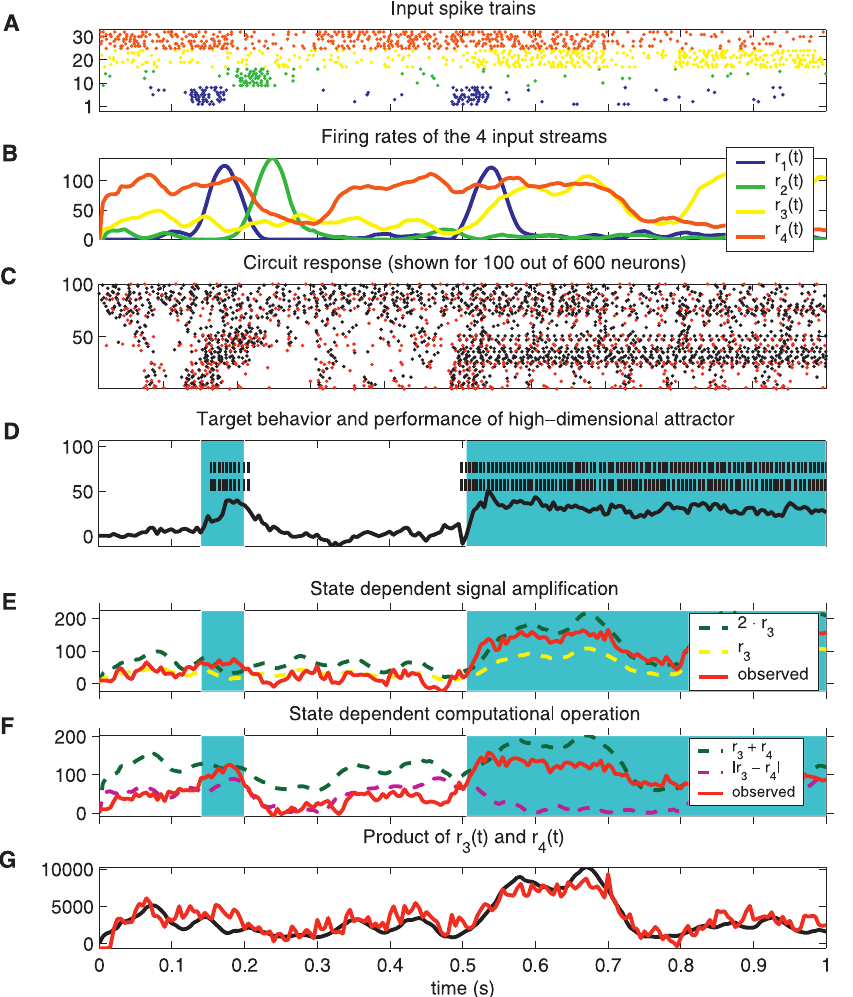
Figure 2. State-Dependent Real-Time Processing of Four Independent Input Streams in a Generic Cortical Microcircuit Model (A) Four input streams, each consisting of eight spike trains generated by Poisson processes with randomly varying rates r i ( t ), i ¼ 1, ... 4, rates plotted in (B); all rates are given in Hz. The four input streams and the feedback were injected into disjoint sets of neurons in the circuit. (C) Resulting firing activity of 100 out of the 600 I&F neurons in the circuit. Spikes from inhibitory neurons marked in red. (D) Target activation times of the high-dimensional attractor (blue shading), spike trains of two of the eight I&F neurons that were trained to create the high-dimensional attractor by sending their output spike trains back into the circuit, and average firing rate of all eight neurons (lower trace). (E,F) Performance of linear readouts that were trained to switch their real-time computation task depending on the current state of the high- dimensional attractor: output 2 (cid:3) r 3 ( t ) instead of r 3 ( t ) if the high-dimensional attractor is on (E), output r 3 ( t ) þ r 4 ( t ) instead of j r 3 ( t ) – r 4 ( t ) j if the high- dimensional attractor is on (F). (G) Performance of linear readout that was trained to output r 3 ( t ) (cid:3) r 4 ( t ), showing that another linear readout from the same circuit can simultaneously carry out nonlinear computations that are invariant to the current state of the high-dimensional